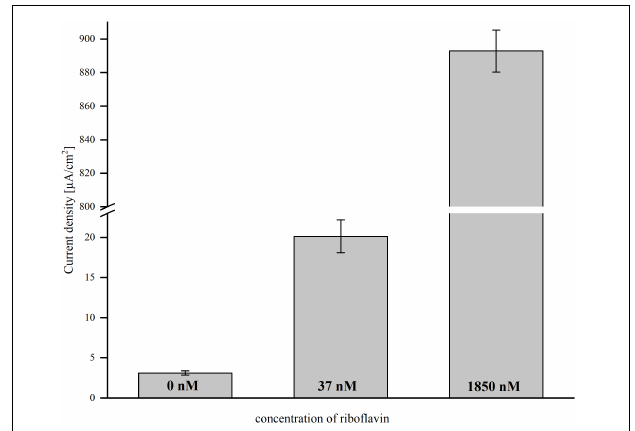
FIGURE 1 | The effect of direct riboflavin addition on average current density in BES with 0, 37, and 1850 nM riboflavin. Error bars represent the standard deviations from means of samples taken in independent triplicates.